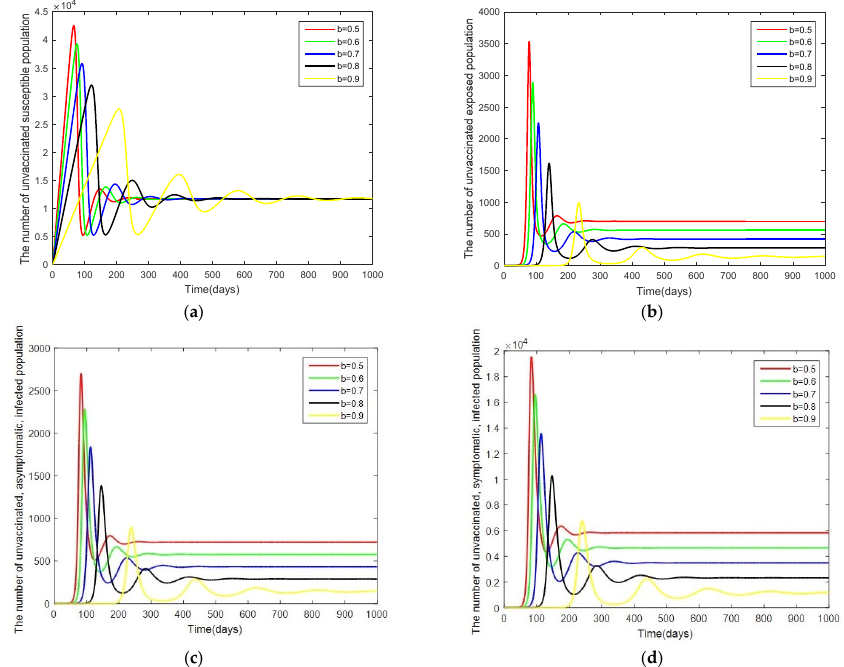
Figure 5. Graphs of the system of Equations (3)–(12) showing the comparison results of efficacy of vaccination ( b ) when R 0 > 1: ( a ) the number in the unvaccinated, susceptible population; ( b ) the number in the unvaccinated, exposed population; ( c ) the number in the unvaccinated, asymptomatic, infected population; and ( d ) the number in the unvaccinated, symptomatic, infected